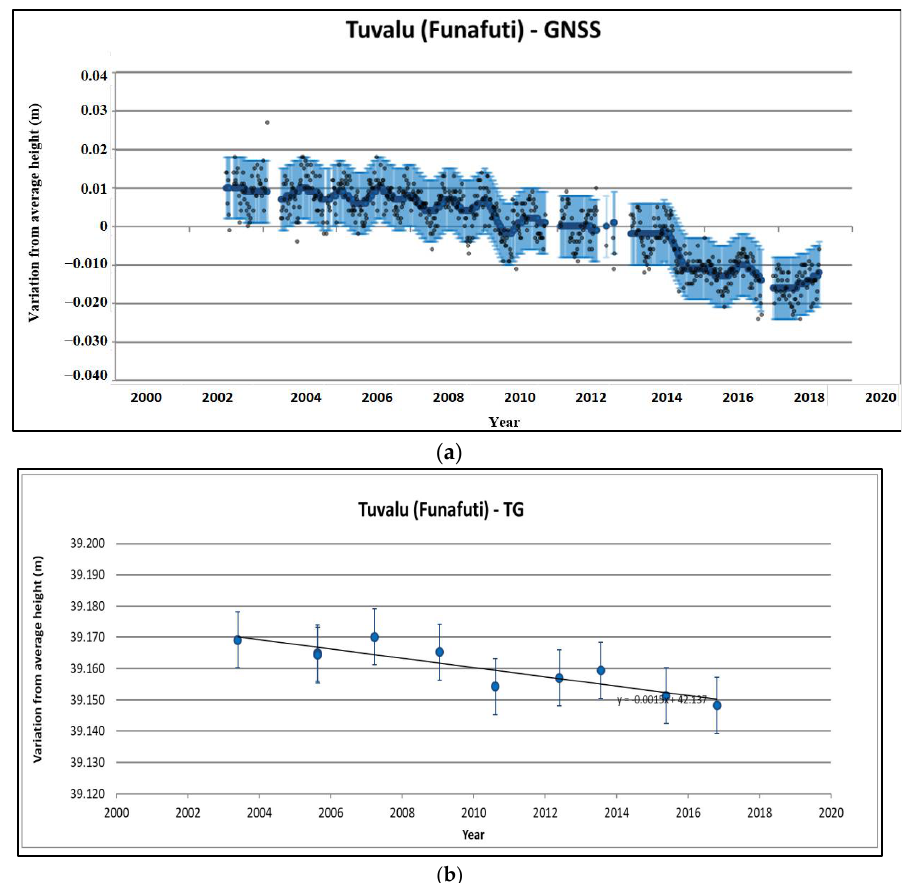
Figure 5. ( a ) The height changes of the GNSS site from the Funafuti tide gauge. The grey dots show the GNSS site heights recorded on a weekly basis. The error bars are shown with the light blue line given at a 95% confidence interval. ( b ) The absolute height change of the tide gauge with the error bars at a 95% confidence interval. Source: Pacific Sea Level Monitoring Project (bom.gov.au accessed on 10 February 2022).